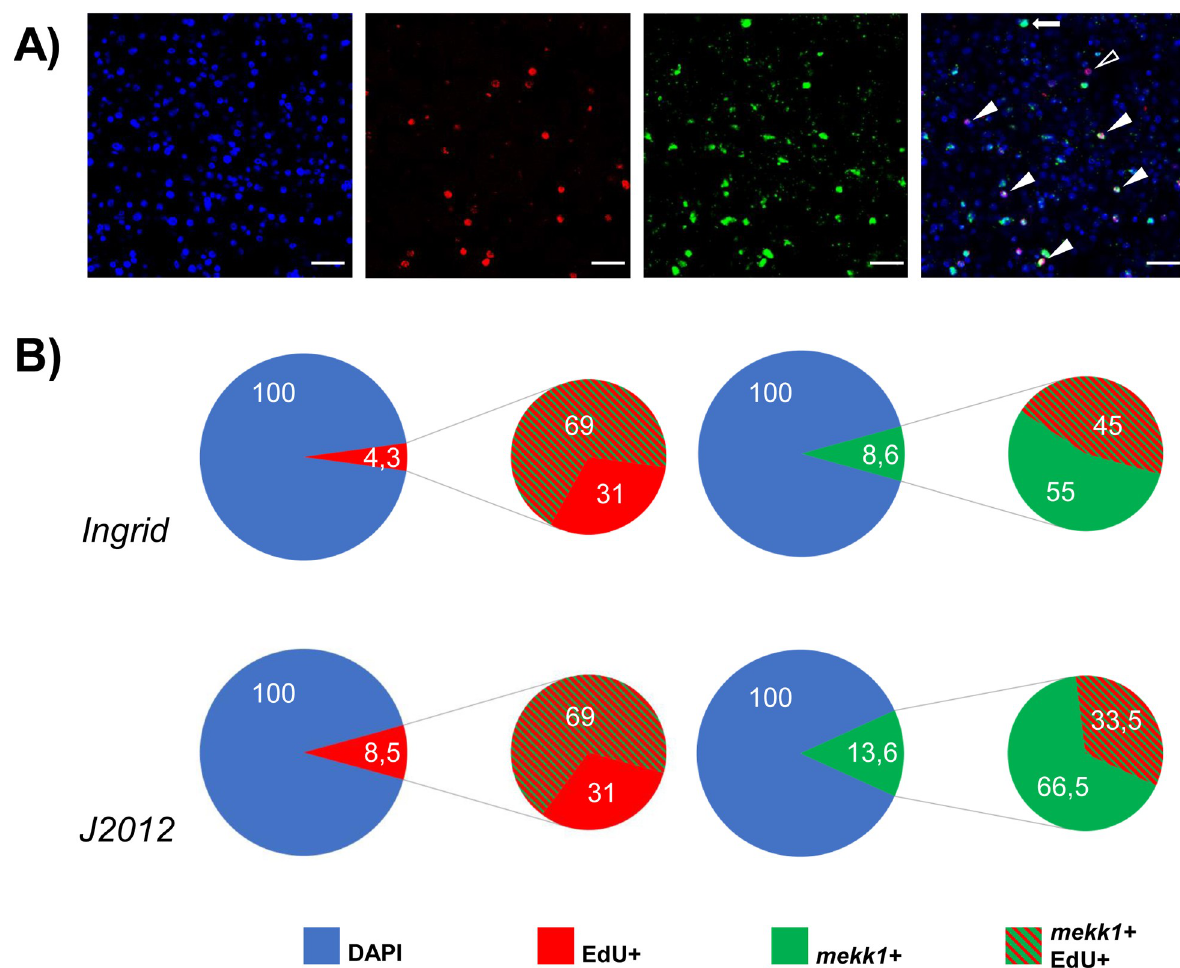
Fig 2. Expression of emmekk1 in metacestode vesicles. A) WISH on vesicle germinal layer. Shown are from left to right: nuclear DAPI staining (blue), EdU detection (red), emmekk1 WISH (green), and merge of all channels. Full triangles indicate cells with double staining for EdU and the emmekk1 -probe, open triangle indicates EdU+ alone, arrow indicates emmekk1 + alone. Bar represents 20 μ m. B) Summary of the WISH results. Values are given in percent for isolates Ingrid (upper panel) and J2012 (lower panel). The color code is indicated below.